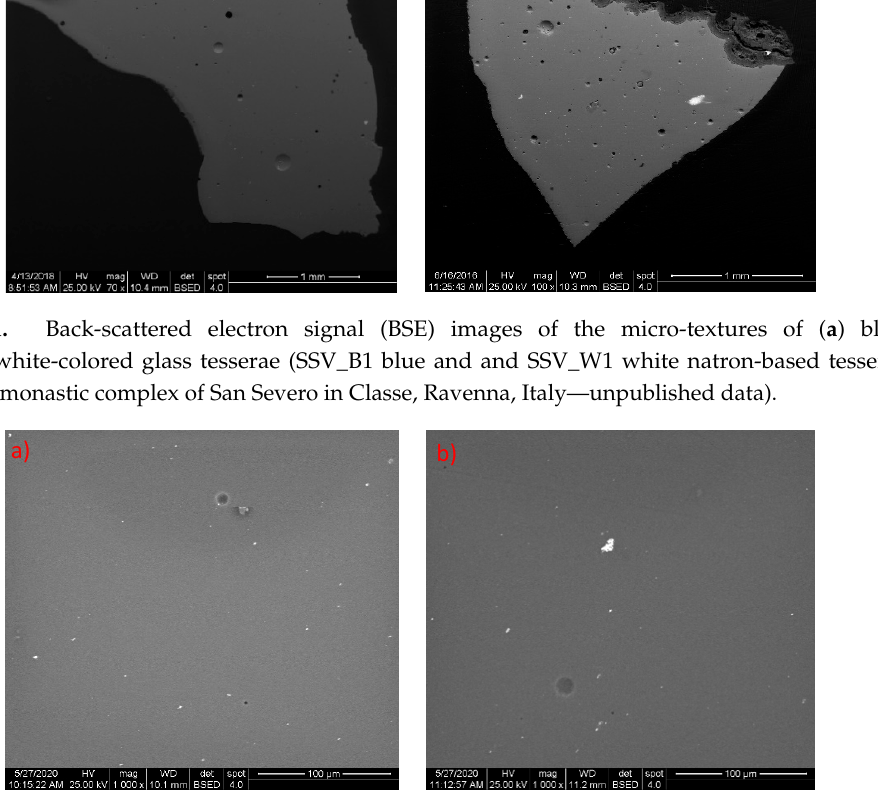
Figure 2. BSE images (1000×) of the micro-textures of ( a ) SSV_B1 blue- and ( b ) SSV_W1 white-colored natron-based tesserae from the monastic complex of San Severo in Classe, Ravenna, Italy—unpublished data. Note that only sporadic inclusions are detectable.